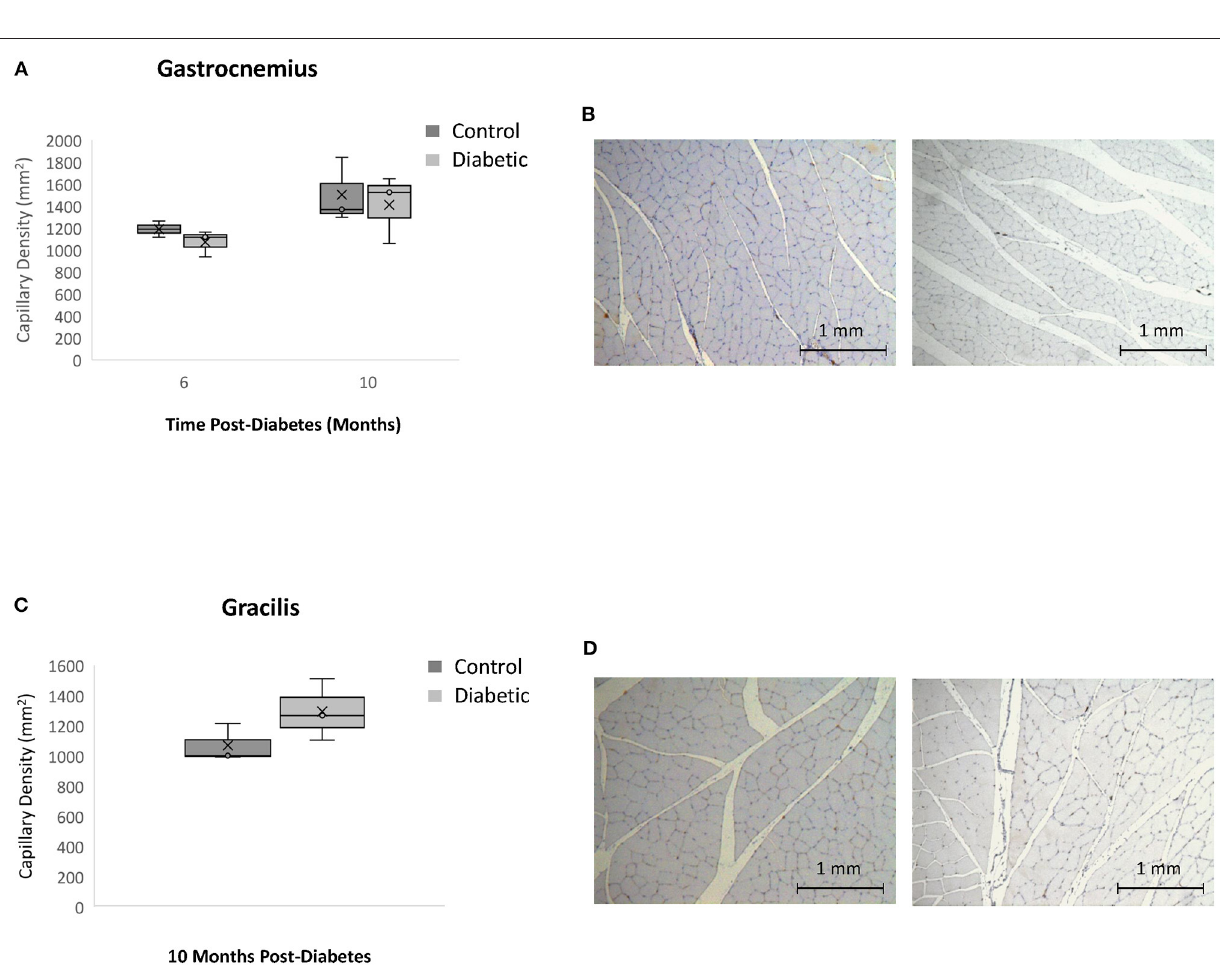
FIGURE 10 | Histology assessment of skeletal muscle capillary density. Timepoints refer to time post-diabetes at 6 months ( n = 2 control, n = 3 diabetic) and 10 months ( n = 3 control, n = 3 diabetic). (A) Gastrocnemius muscle capillary density quantified as the number of vessels per mm 2 of tissue on CD31 stained sections. (B) Gastrocnemius sections stained with CD31 of control (left) and diabetic (right) rats at 10 months post-diabetes. (C) Gracilis muscle capillary density quantified as the number of vessels per mm 2 of tissue on CD31 stained sections. (D) Gracilis sections stained with CD31 of control (left) and diabetic (right) rats at 10 months post-diabetes. Box plot mean value is represented with the symbol